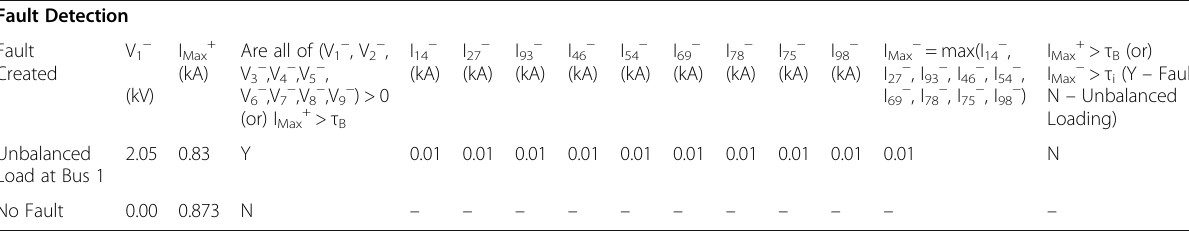
Table 4 Verification of Fault Detection algorithm in WSCC Nine Bus System Fault Detection Fault